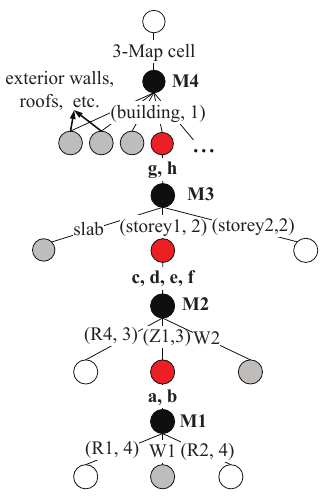
Figure 3. An extended maptree example of Figure 4